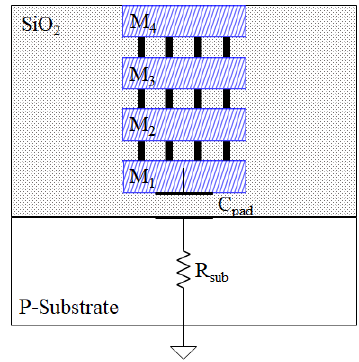
Figure 3. Cross-section of the pad capacitance and substrate